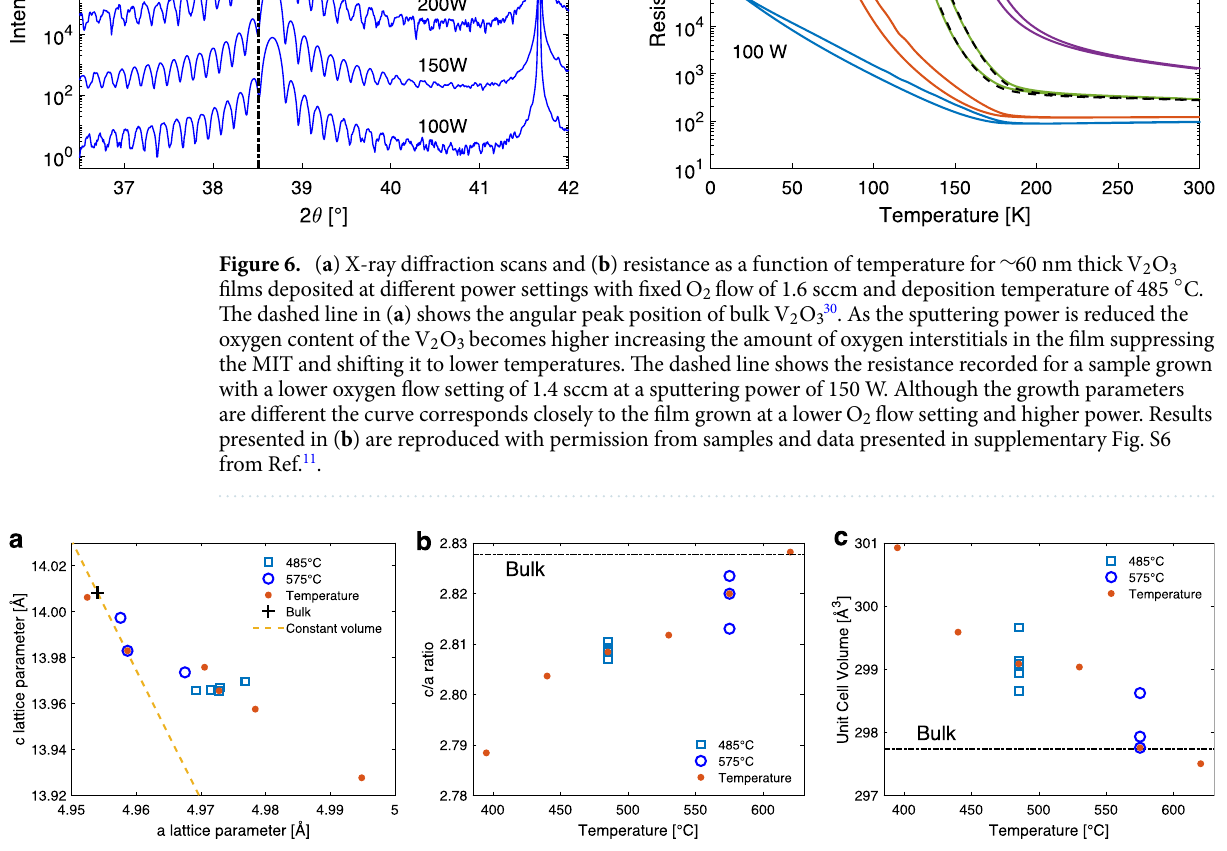
Figure 7. ( a ) The c lattice parameter plotted as a function of the a lattice parameters for all of the films. Constant unit cell volume is shown by the dashed line. Different growth series are labelled with different points. ◦ There are two oxygen flow rate series at fixed temperatures. At 485 C the flow rate ranges between 1.4 and ◦ 2.0 sccm, and at 575 C it ranges between 1.4 and 1.8 sccm. The temperature series was grown at the fixed oxygen flow rate of 1.6 sccm. ( b ) c / a ratio and ( c ) lattice unit cell volume as a function of growth temperature. The dashed lines correspond to bulk values for V 2 O 3 . Overlapping points correspond to the same data within different